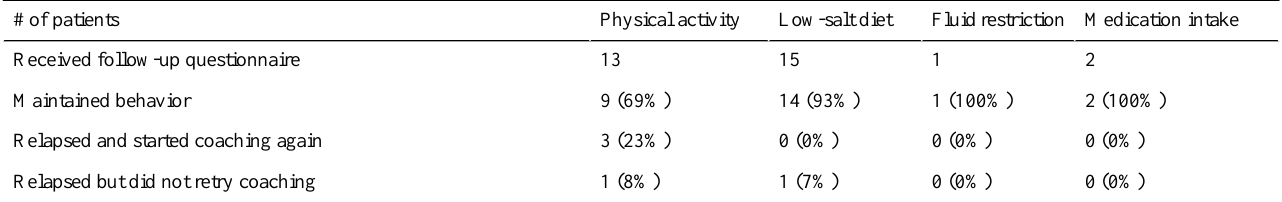
Table 3. Patient responses to follow-up questionnaires (N=123).